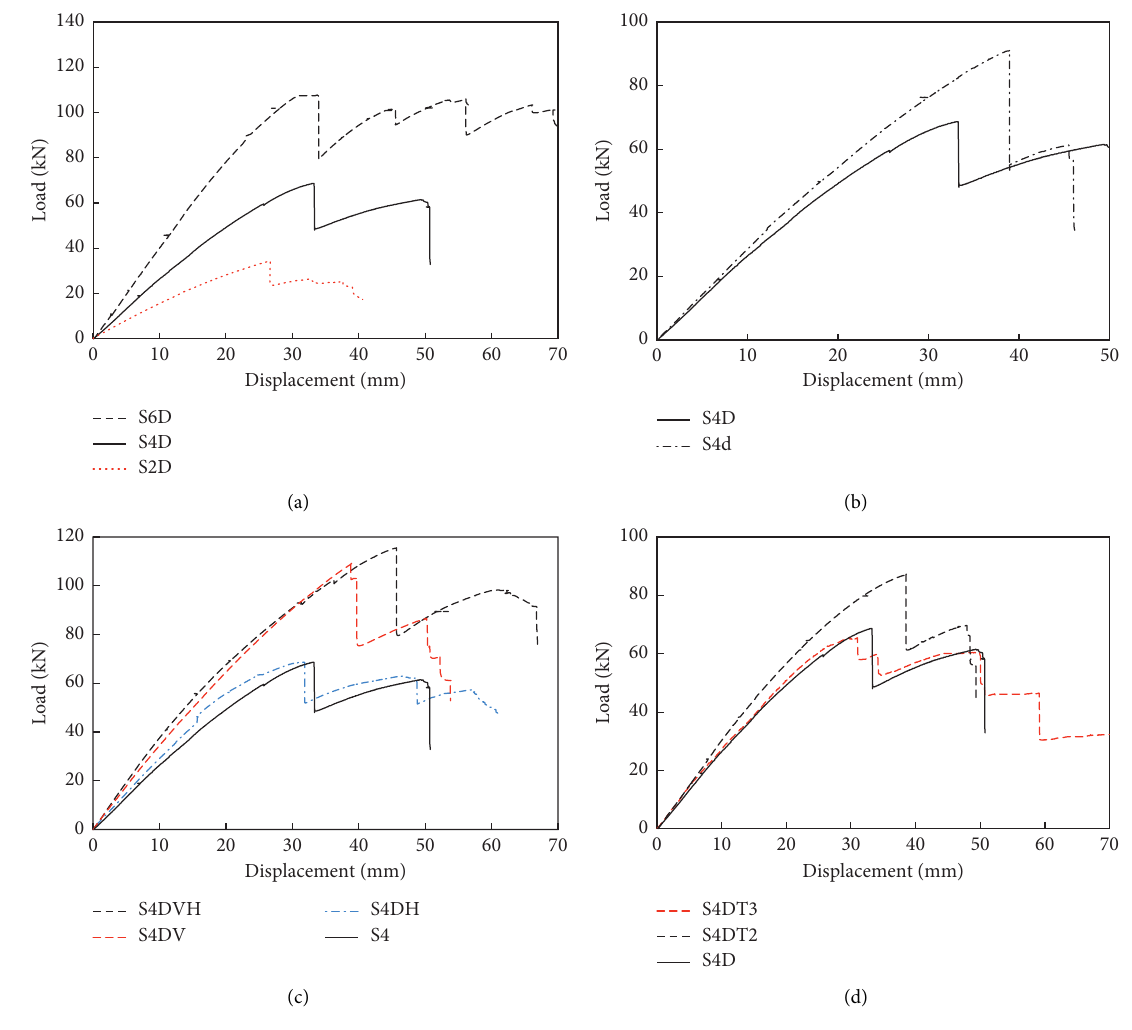
Figure 6: Load-displacement